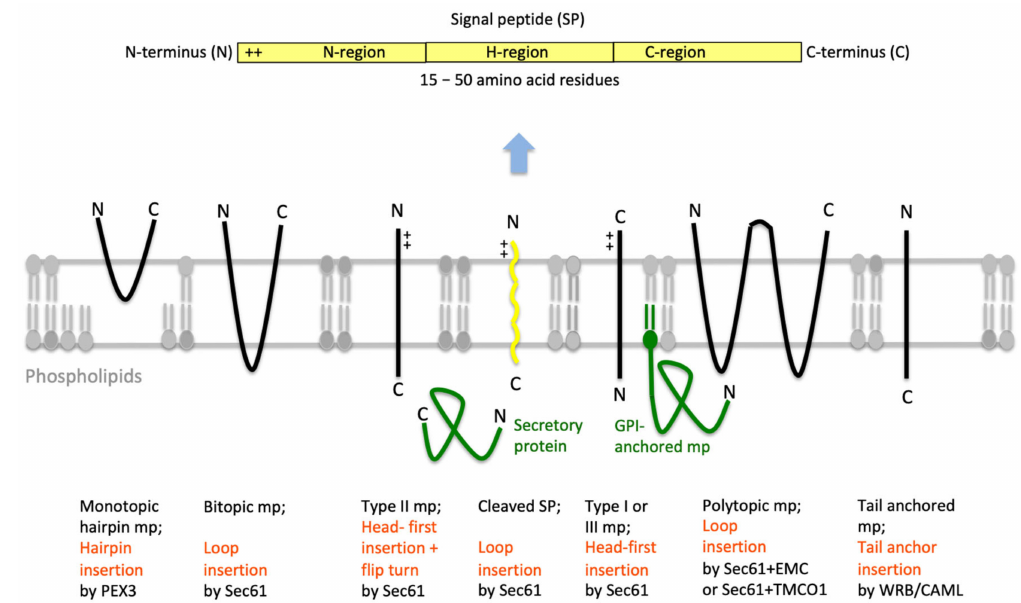
Figure 4. Features of amino-terminal signal peptides and ER membrane proteins. The cartoon depicts the signal peptides (SPs, shown in yellow) and six types of ER membrane proteins (in black), together with their membrane protein type and mechanism of membrane insertion (both indicated below the cartoon). Cleavable SPs (in yellow) can facilitate ER import of secretory proteins (in green), glycosylphosphatidylinositol (GPI)-anchored membrane proteins (in green) and various types of membrane proteins, except for hairpin-, type II- and tail anchored-membrane proteins. Positively charged amino acid residues (+) play an important role in membrane protein and SP orientation, i.e. typically, follow the positive inside rule. Bitopic and polytopic proteins can also involve SPs and have the opposite instead of the shown orientation. Alternatively, amino-terminal transmembrane helices (TMHs), which serve as SPs, facilitate membrane insertion. The shown bitopic protein is also named double-spanning membrane protein, the example polytopic protein is also named tetra-spanning membrane protein, if the shown type I membrane protein did not involve a cleavable SP it is also defined as signal anchor protein. In the case of membrane proteins with amino-terminal TMHs, membrane insertion typically involves the same components and mechanisms, which deliver secretory proteins (in green) and glycosylphosphatidylinositol (GPI)-anchored membrane proteins (in green) to the ER lumen. In certain cases, however, auxiliary membrane protein insertases, such as EMC or TMCO1 complex play a role. The latter two membrane protein complexes can also operate as stand-alone membrane protein insertases, an activity they have in common with the PEX- and the TRC-systems. Following their ER import, GPI-anchored membrane proteins become membrane anchored via their carboxy-termini by GPI-attachment. C, carboxy-terminus; N,